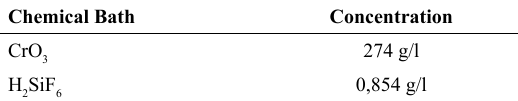
Table 1. Chemical bath for electrolytic deposition Chemical Bath